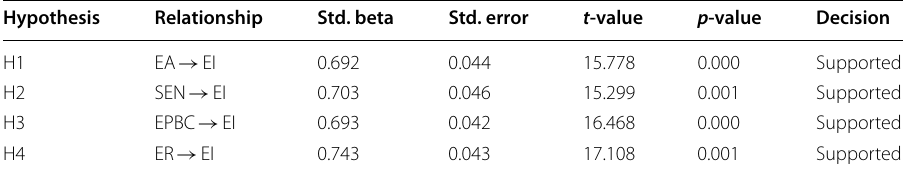
Table 6 Result of direct and indirect effect hypotheses Hypothesis Relationship Std. beta Std. error t -value p -value